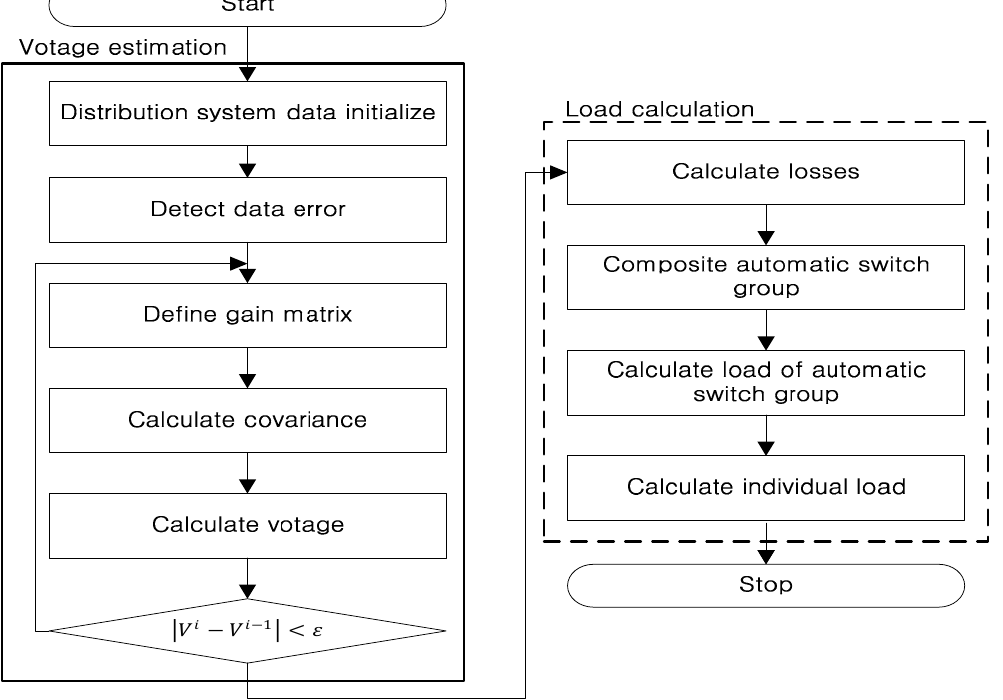
Figure 3. Algorithm of the distribution system data acquisition.